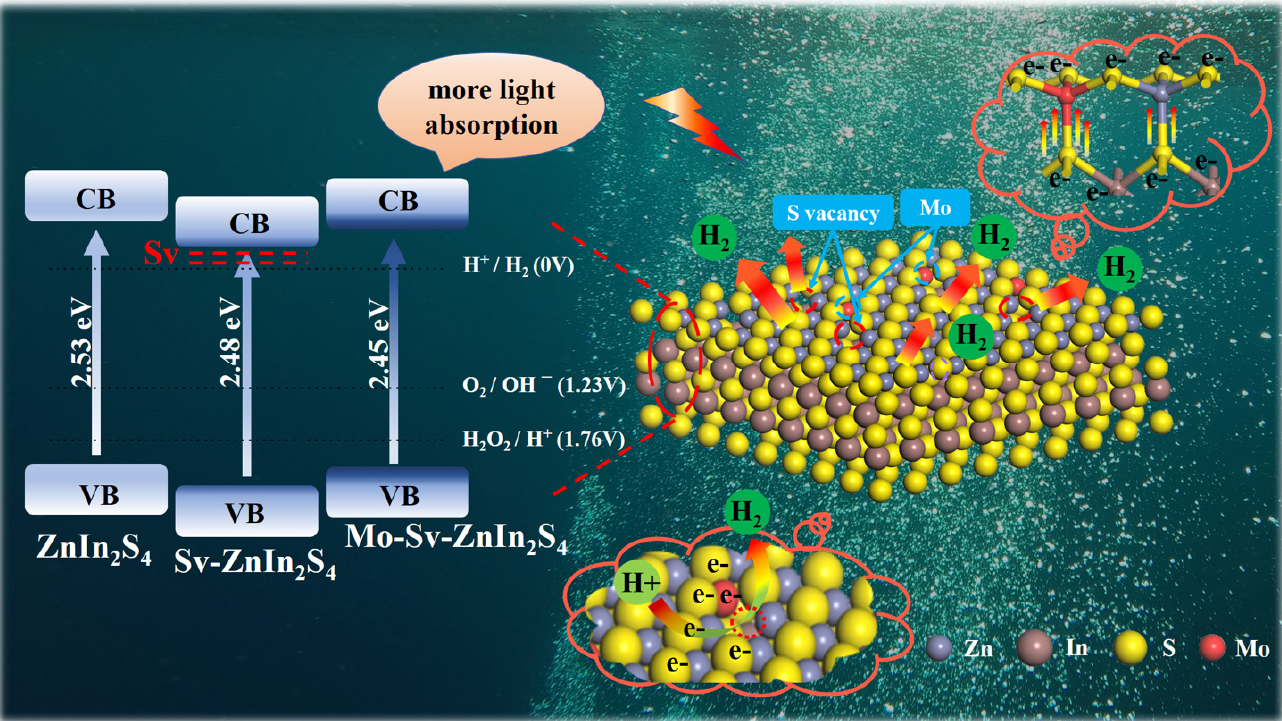
Figure 7. Schematic illustration explaining the excellent photocatalytic activity of the